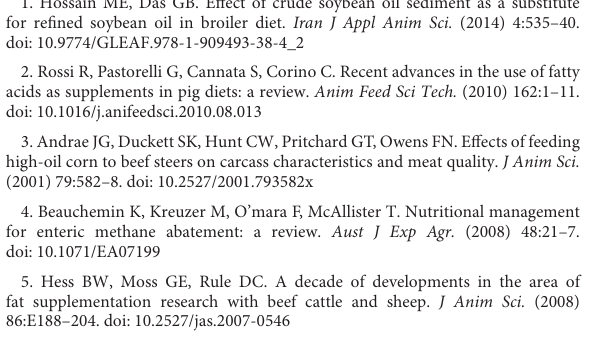
SUPPLEMENTARYTABLE1 Summary of sequencing data and average length. SUPPLEMENTARYTABLE2 Relative abundances at the phylum level across samples. SUPPLEMENTARYTABLE3 Relative abundances at the genus level across